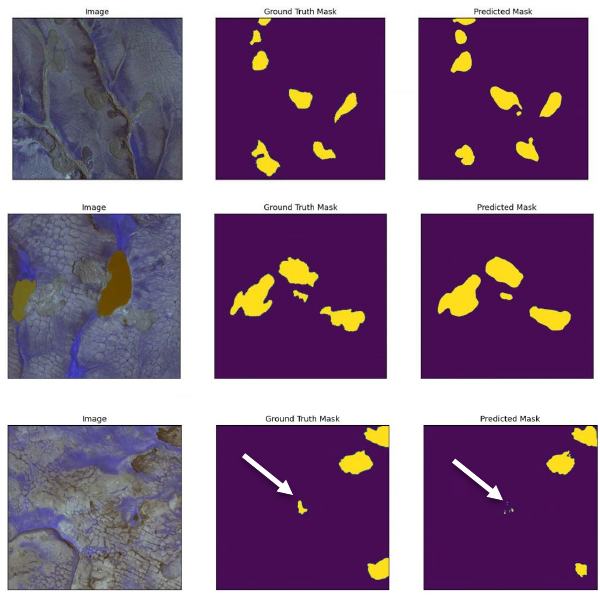
Figure 13 . Three image sample tiles of the test dataset and the ground truths and predicted masks of those images. (Imagery © 2016 DigitalGlobe,